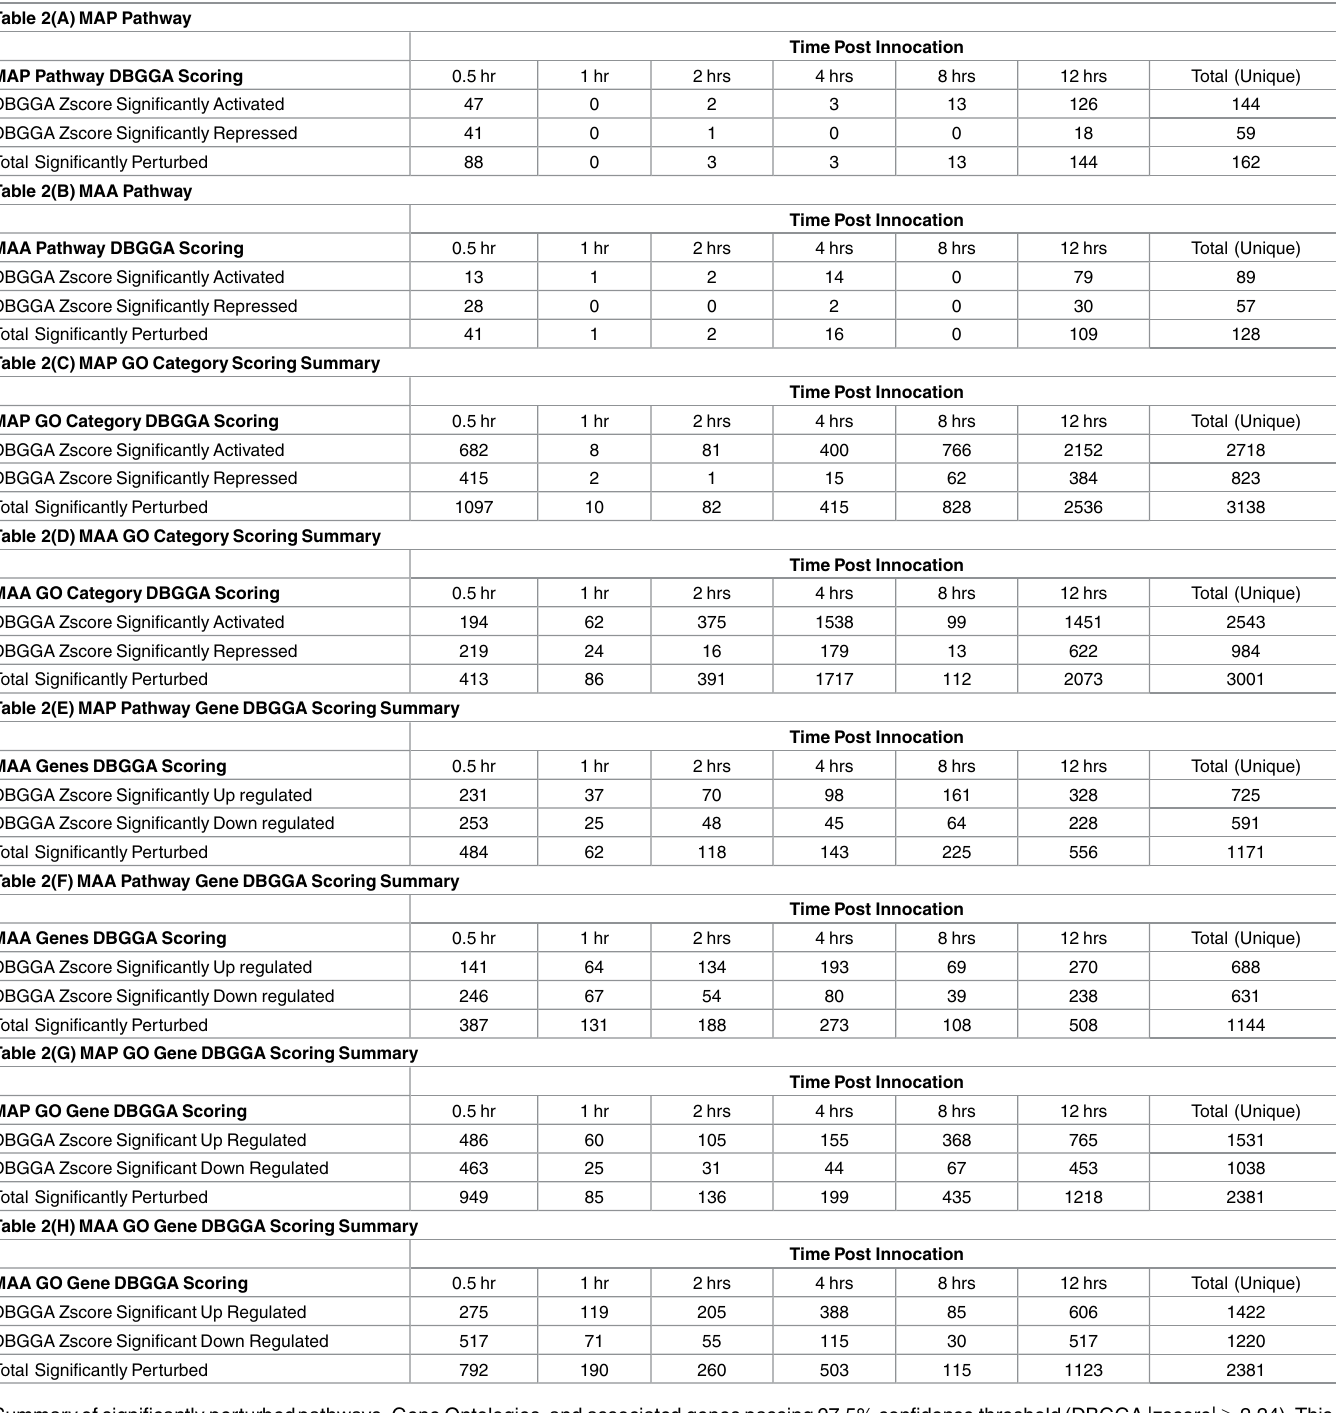
Table 2. DBGGAScoringSummariesfor Pathways and Gene Ontologies for boththe MAP and MAA Conditions. Table 2(A)MAP Pathway